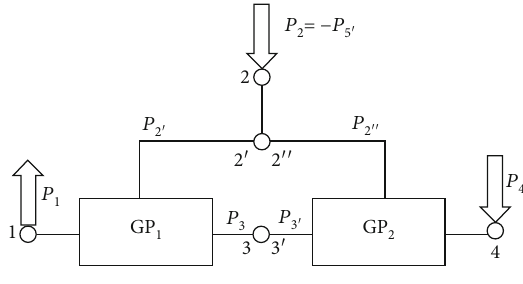
, ω , ω , and ω > 0 . 4 1 2 3